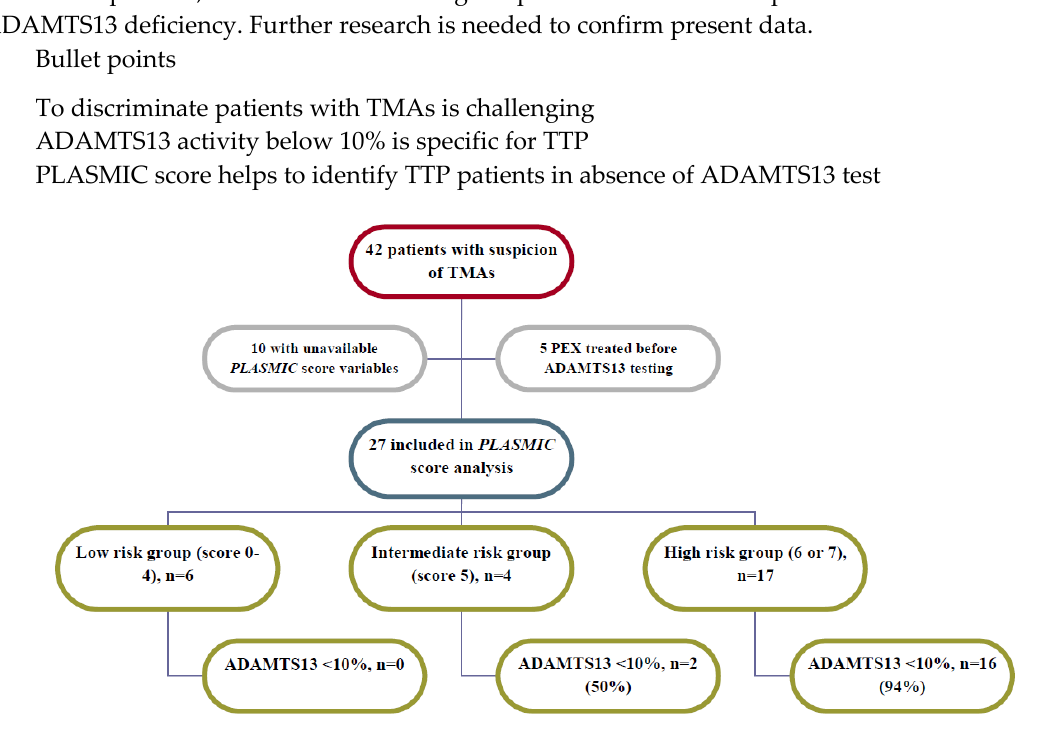
Figure 1. Flow chart describing patients observed from January 2012–September